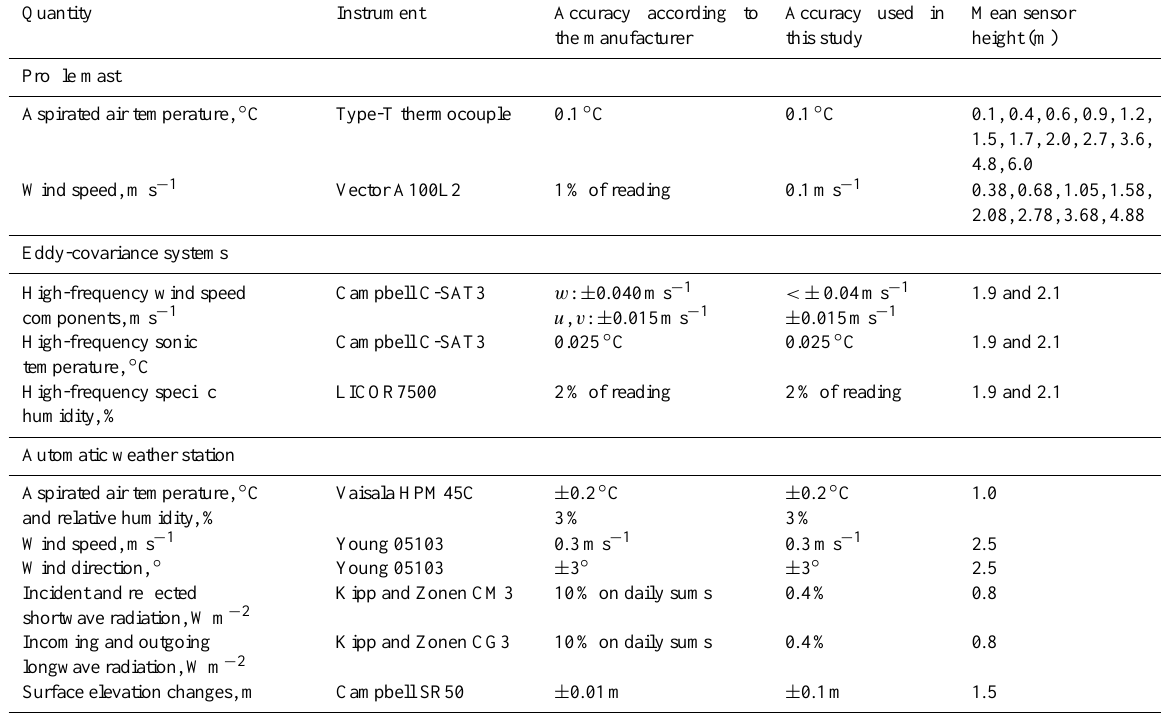
Table 1. Characteristics of the sensors from the automatic weather station, eddy-covariance systems and profile mast. Shown are random errors in measurements provided by the manufacturer and those used in this